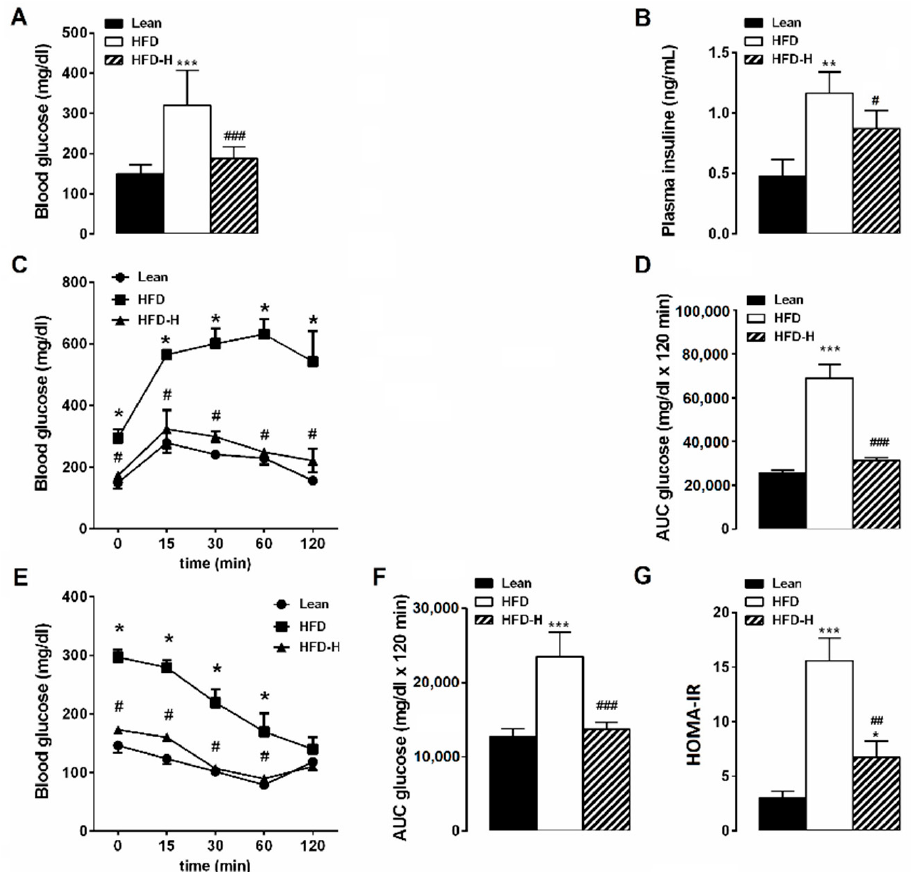
Figure 2. Effects of long-term honey ingestion on glucose metabolism in HFD mice. Honey prevented the glucose dysmetabolism. ( A ) Fasting glucose concentration; ( B ) Fasting insulin